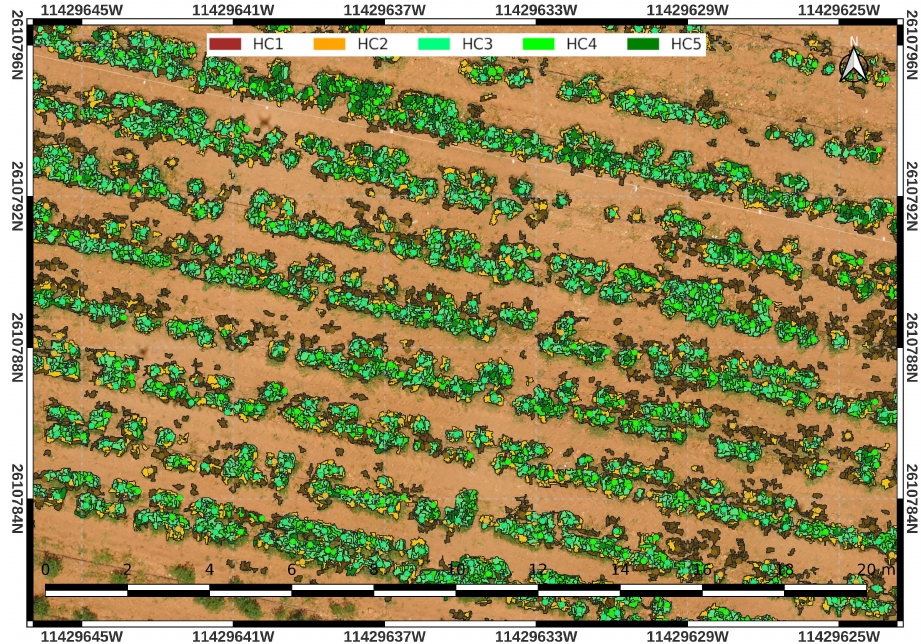
Figure 13. LSMSS with spatial KMeans plant detection and leaf segmentation at orthomosaic level